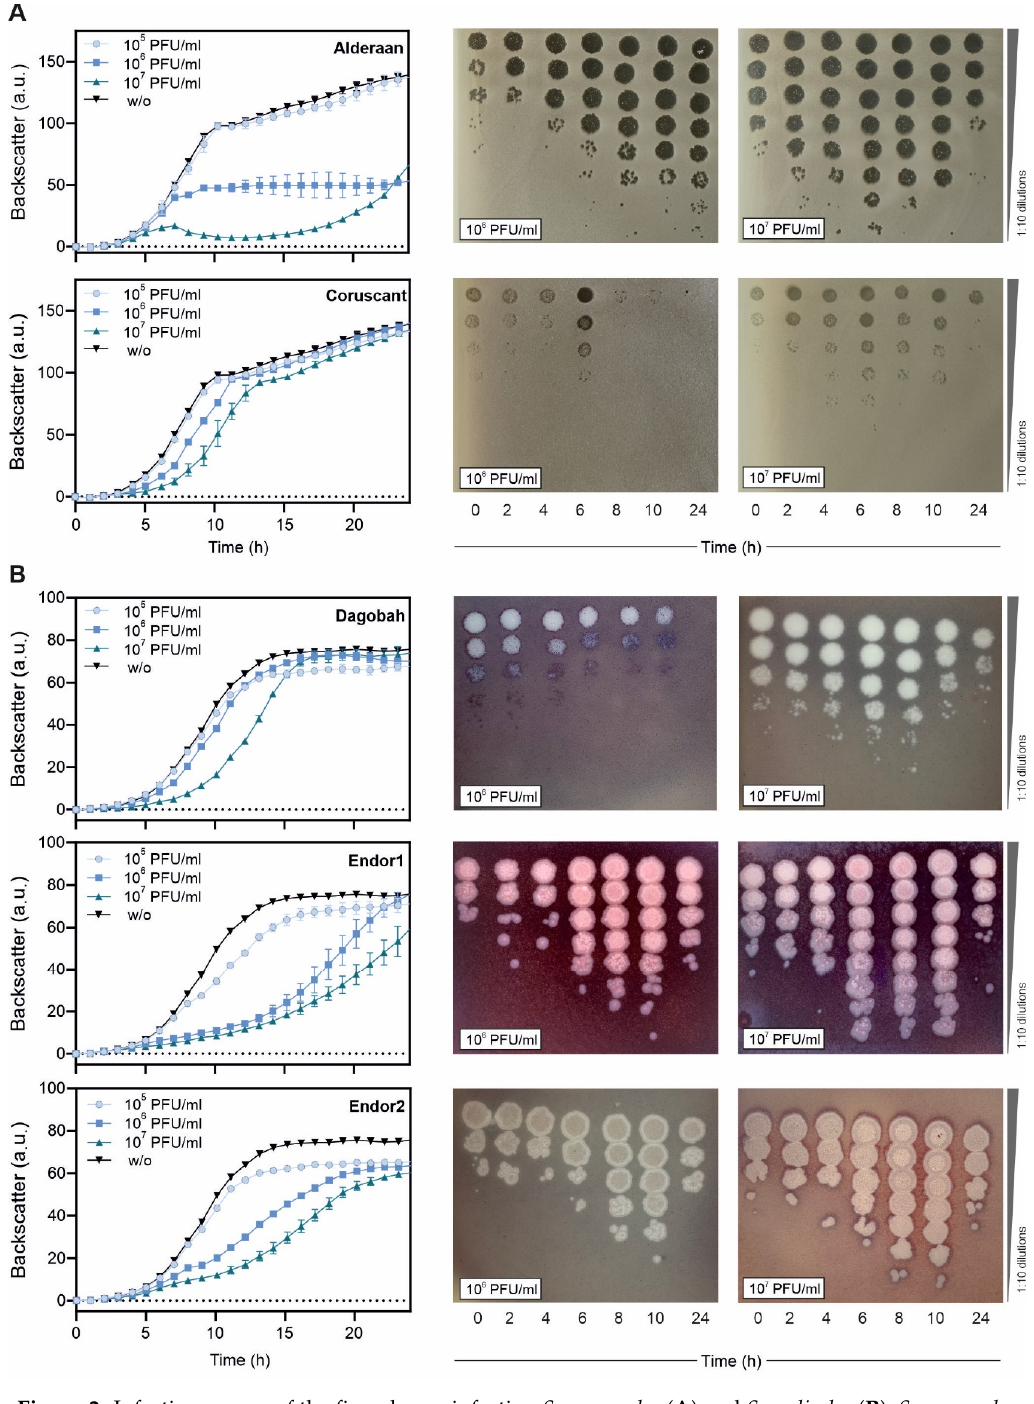
Figure 2. Infection curves of the five phages infecting S. venezuelae ( A ) and S. coelicolor ( B ). S. venezuelae or S. coelicolor were inoculated to GYM or YEME medium, respectively, and grown in microtiter plates, to which phages were added at the indicated initial phage titers. Backscatter was measured over time (left panels), in parallel to phage titers (right panels).